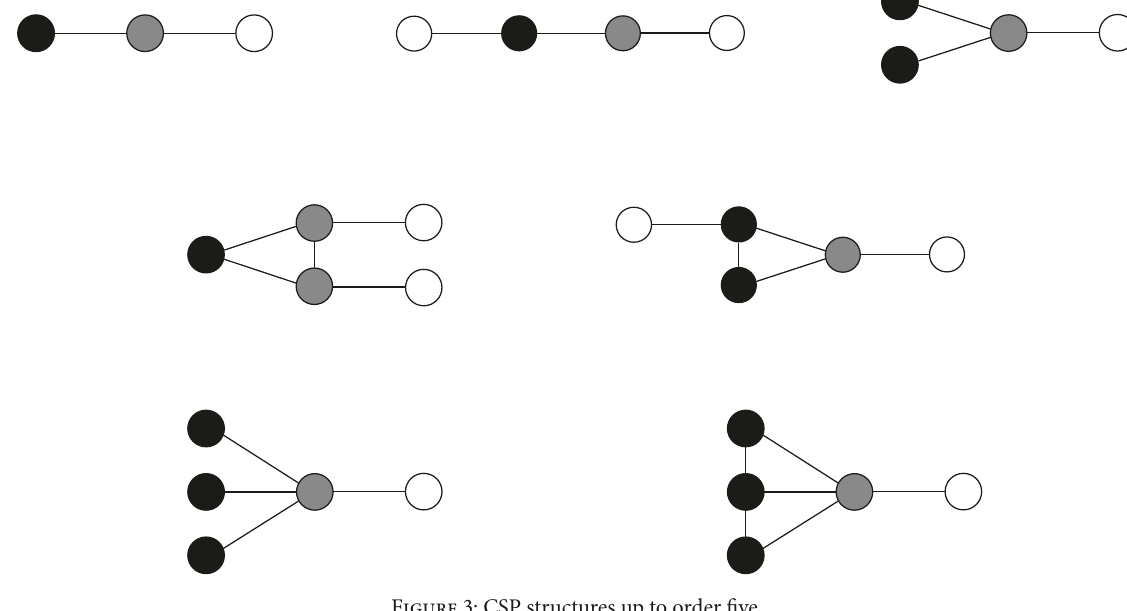
Figure 3: CSP structures up to order five.